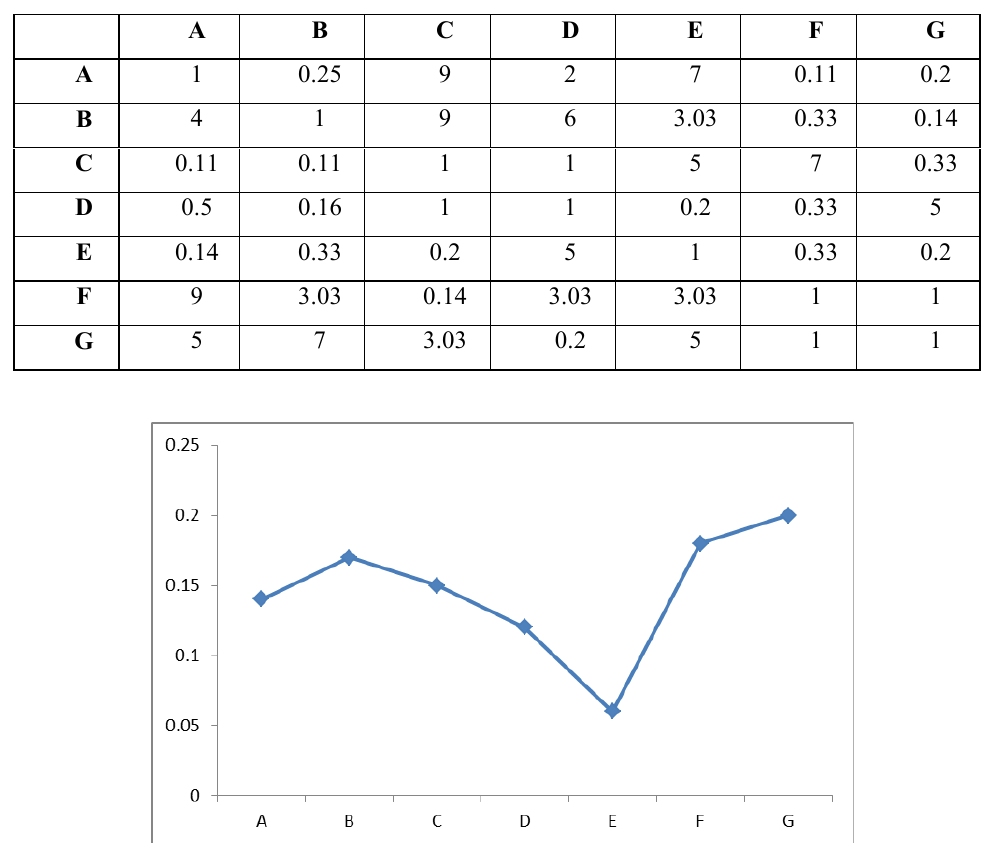
Fig. 1. The values and effeteness of each factor according to calculations and the matrix obtained, and the hierarchical analysis process technique (developed by the